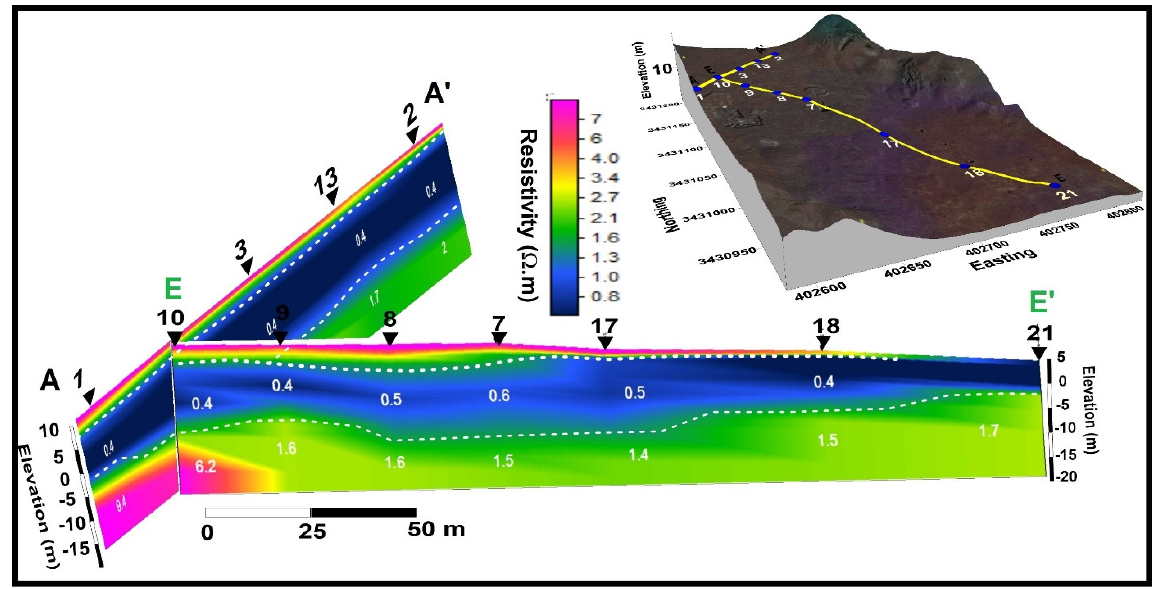
Figure 6. Fence diagram of resistivity cross-sections; white dashed lines represent archaeological layer boundaries, and the values are true resistivities.